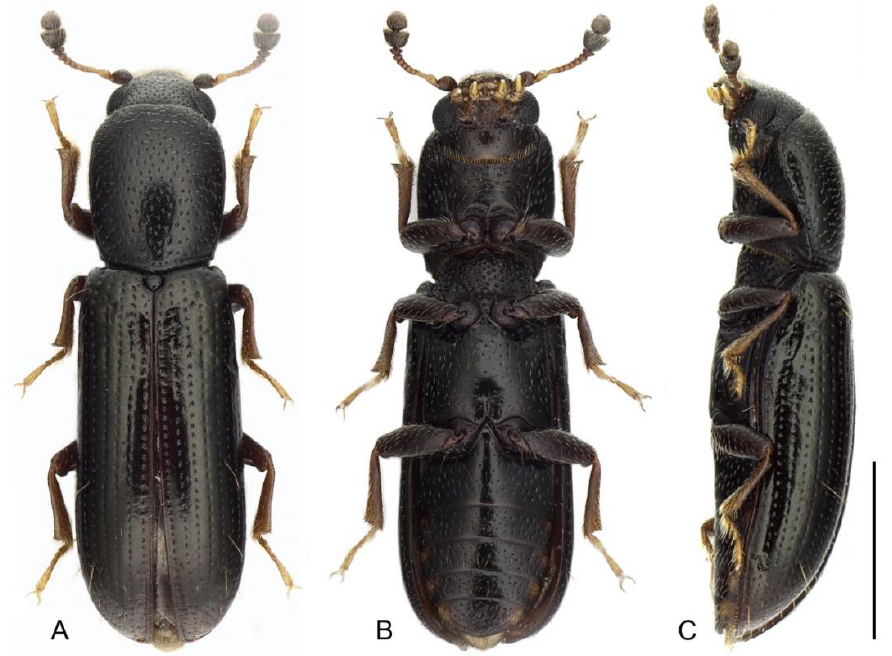
Figure 1. Teredus chinensis sp. nov., holotype, male: ( A ) dorsal view; ( B ) ventral view; ( C ) lateral view. Scale bar: 1 mm.